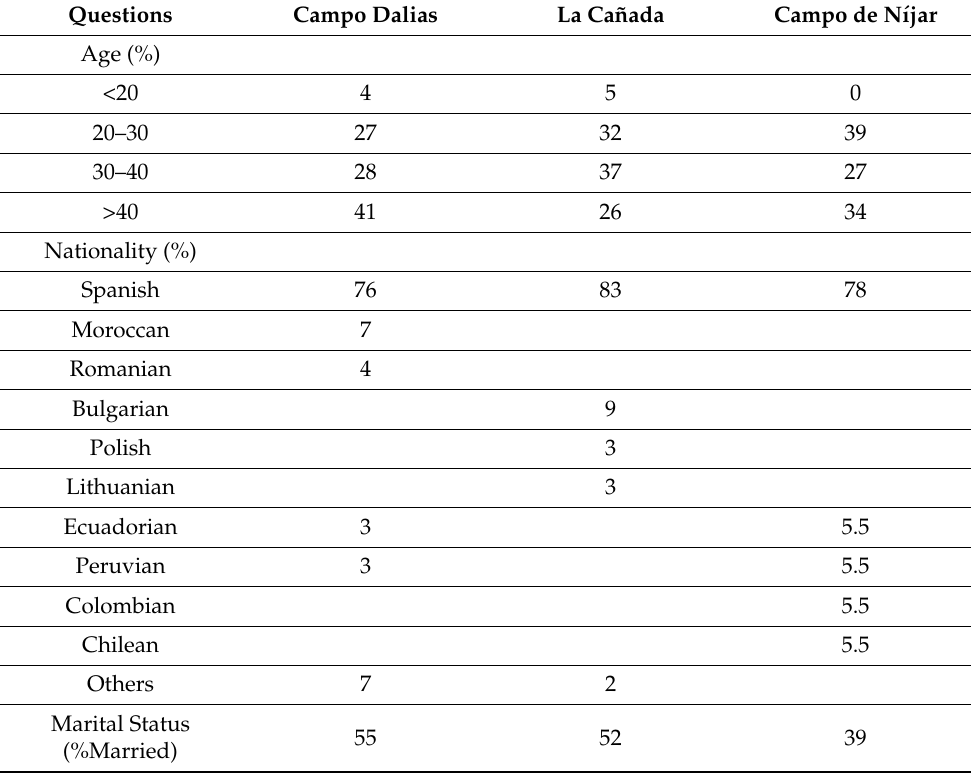
Table 2. Horticultural areas